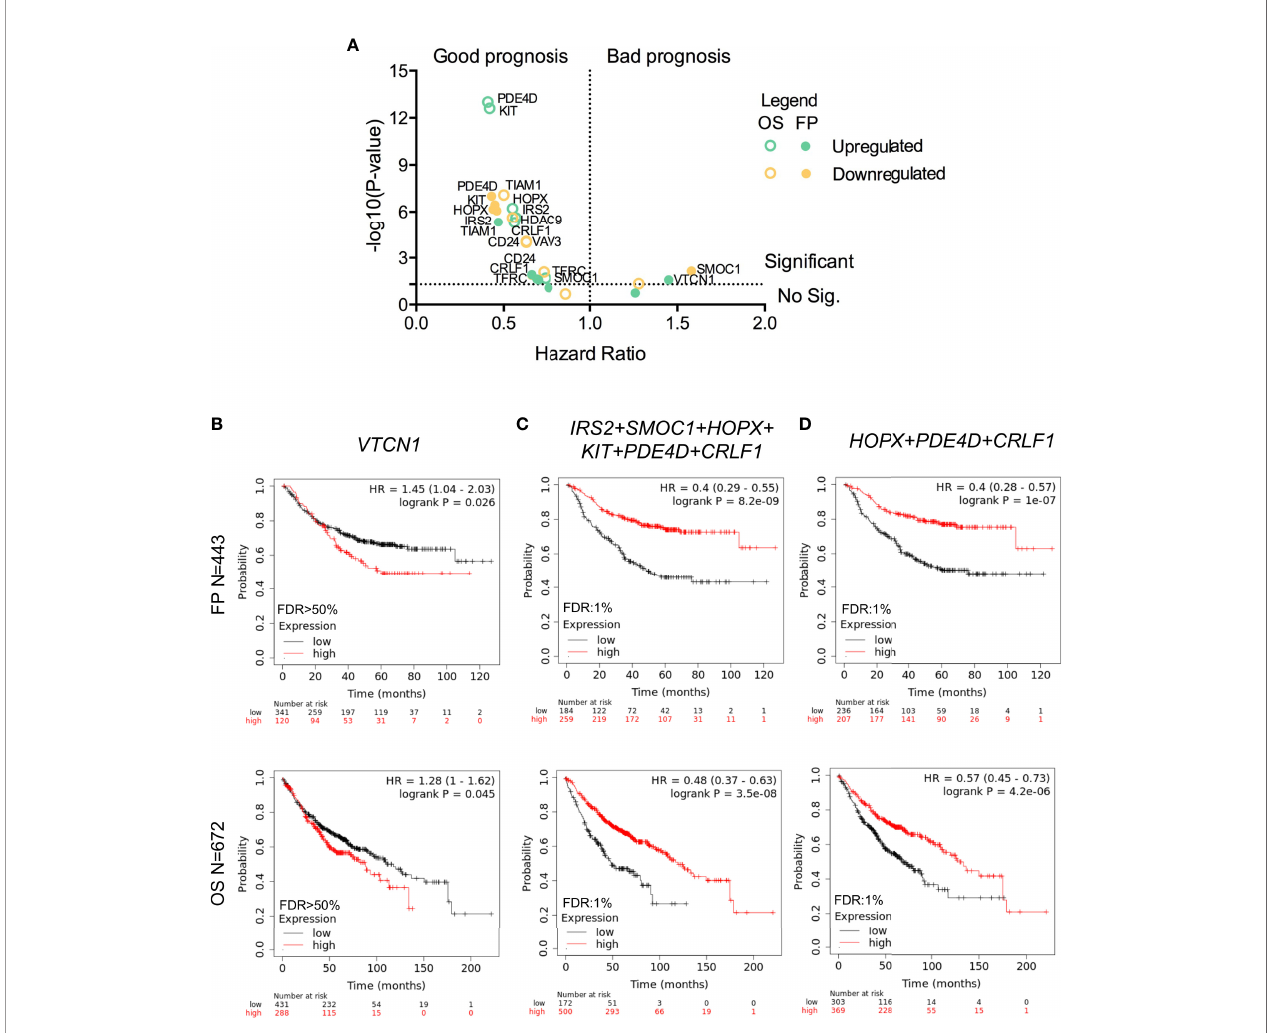
FIGURE 3 | Association between gene expression and LUAD survival. (A) Dot plot indicating the – log (P-value) and hazard ratio from Kaplan-Meier of the individual expression of the thirteen selected genes (green for upregulated and yellow for downregulated ones) to FP ( fi lled dots) or OS (empty dots). Kaplan-Meier survival plots showing the association between the single ( VTCN1 in B ) or combined gene expression levels ( IRS2, SMOC1, HOPX, KIT, PDE4D , and CRLF1 in (C) ; and HOPX, PDE4D , and CRLF1 in D ) with FP (above) and OS (below) for